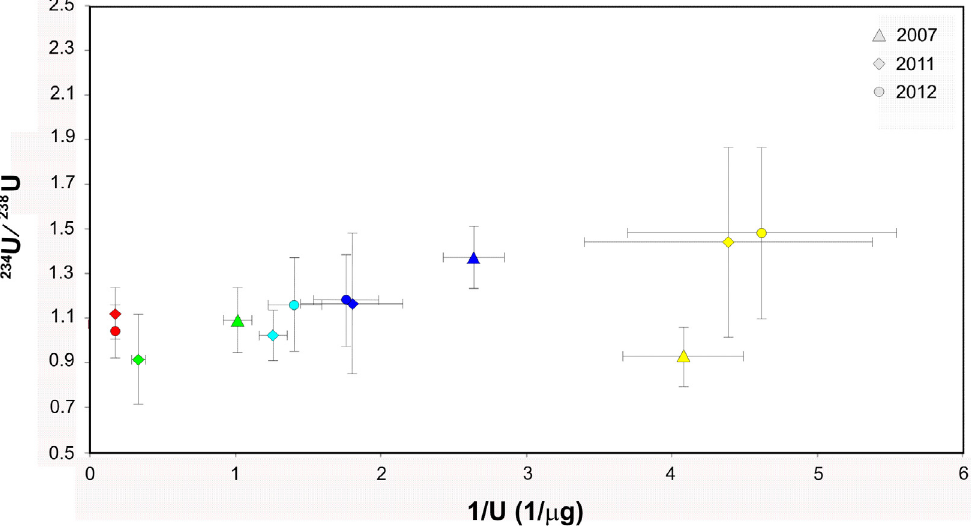
Figure 2. Graphical correlation between 234 U/ 238 U activity ratios and the inverse of uranium concentration values (1/U) in investigated wa- ters from the eastern flank of Mt. Etna in three different years of sampling (data for 2007 survey are taken from Kozłowska et al. [2009]; data for 2011 and 2012 surveys are from this